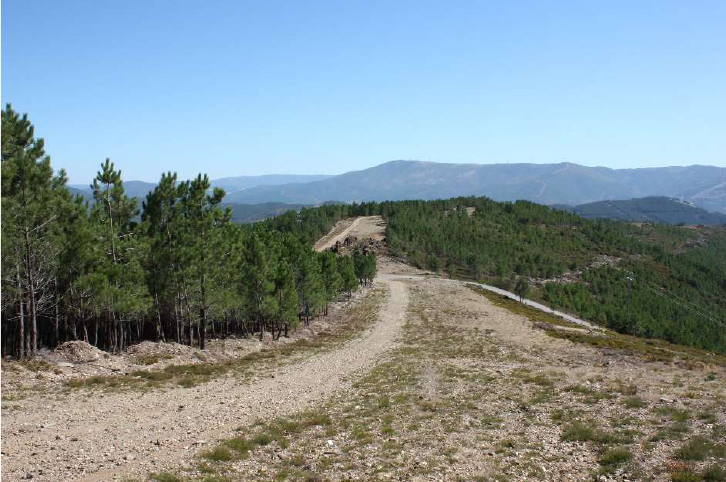
Figure 2. Ground observation of an FB. (Source: http://www2.icnf.pt/).